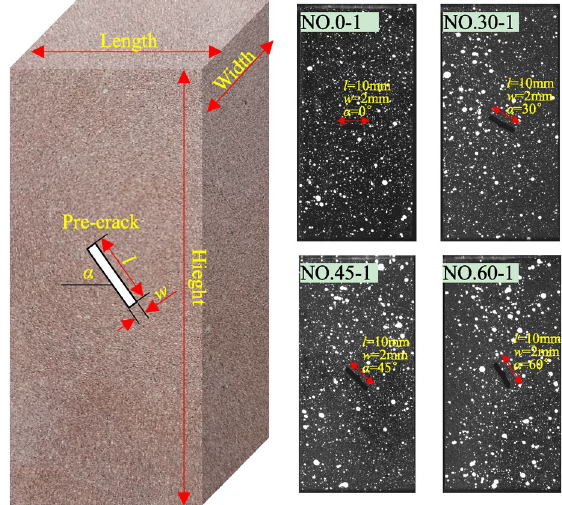
Figure 1. Geometric dimensions and speckle field of some